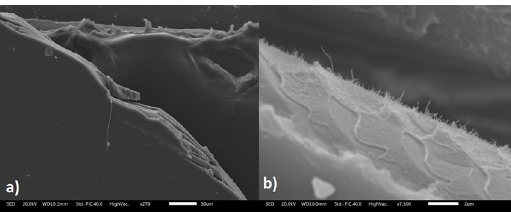
Figure 3. SEM micrographs: a) polymer surface, b) sandwich arrangement.